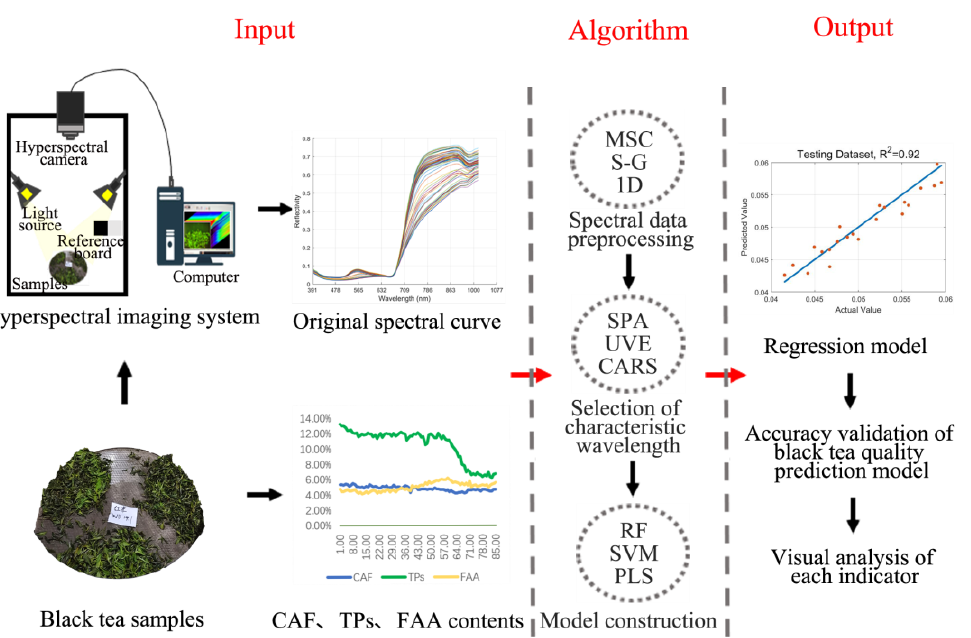
Figure 1. Acquisition and analysis of hyperspectral data.